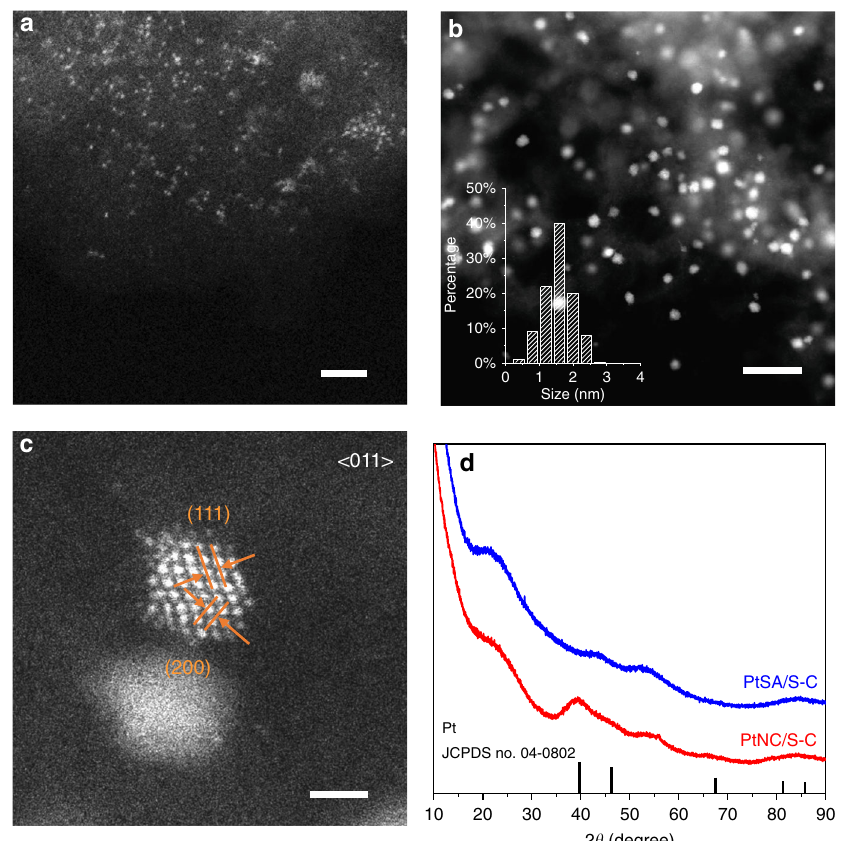
Fig. 2 Structural characterization of PtSA/S – C and PtNC/S – C. a HAADF-STEM image of PtSA/S – C. Scale bar, 2 nm. b HAADF-STEM image of PtNC/S – C. Scale bar, 10 nm. c High-resolution HAADF-STEM image of PtNC/S – C. Scale bar, 1 nm. d XRD patterns of PtSA/S – C and PtNC/S – C. The standard peaks of Pt are shown in black